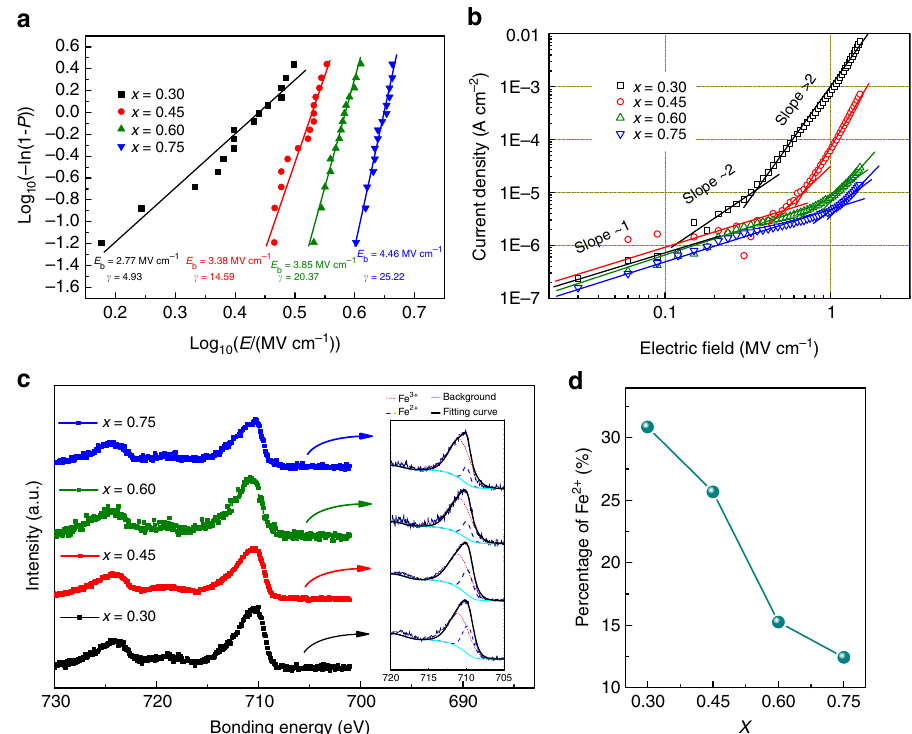
Fig. 5 Breakdown strength and electric conduction. a Two-parameter Weibull Distribution analysis of dielectric breakdown strengths, b room-temperature leakage current densities as a function of biased electric fi eld, c XPS fi tting for Fe valences and d percentage of Fe 2 + out of all Fe ions in the BFSTO fi